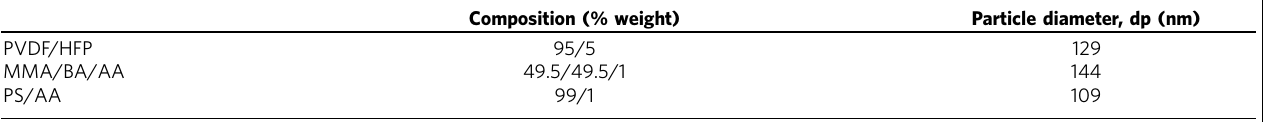
Table 1 | Main characteristics of the three water-based polymer dispersions employed to prepare the polymer